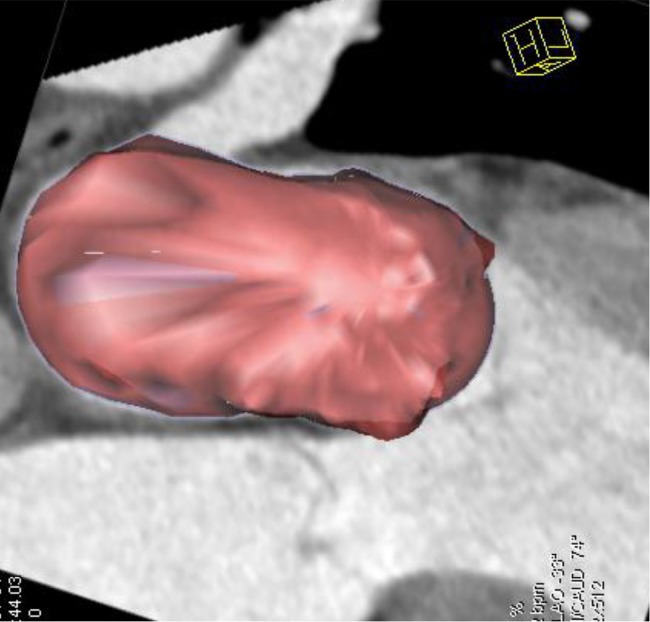
2D and 3D fusion image of LA.The fusion image providing true 3D rendering of LA without taking any geometrical assumptions.